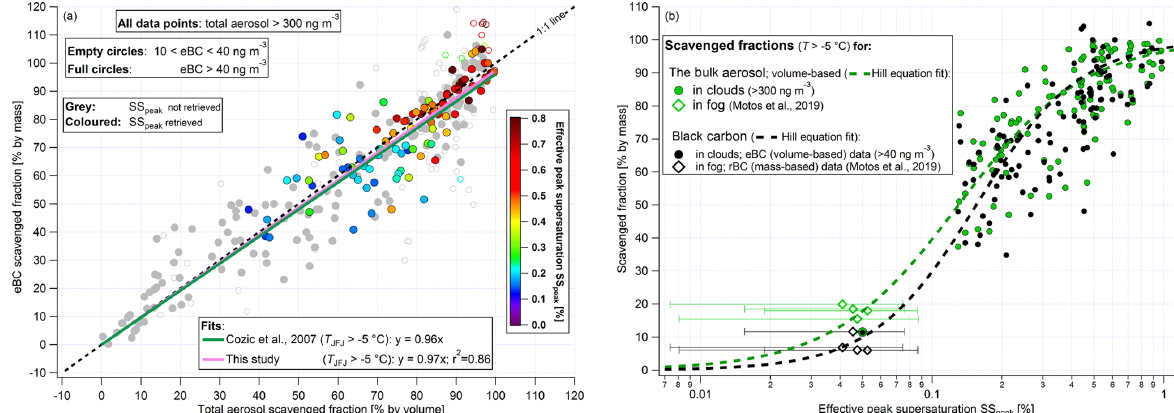
Figure 8. eBC mass scavenged fractions derived from the two MAAPs and aerosol volume scavenged fractions derived from the two SMPSs during all liquid clouds. (a) Correlation of these two scavenged fractions with cloud effective peak supersaturation indicated by the colour, when available. (b) Dependence of scavenged fraction on cloud effective peak supersaturation. This panel additionally contains equivalent data from measurements in fog at an urban site (Motos et al., 2019). The coefficients of the manually fitted Hill equations (dashed lines) are provided in the Supplement. Open symbols are used in both panels for data points with concentrations close to the detection limits of the MAAP or SMPS (BC mass in the range 10–40ngm − 3 or total volume ≤ 200µm 3 cm − 3 ). Both panels are based on liquid clouds only. Potential mixed-phase clouds were filtered by excluding all data at temperatures below − 5 ◦